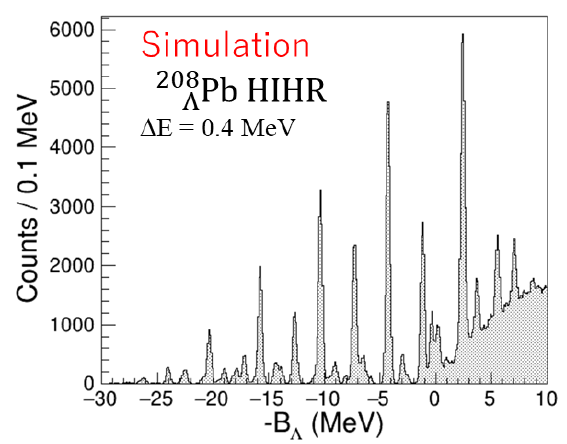
Figure 9. Expected Λ binding energy spectrum of 208 Λ Pb to be measured at HIHR. Major peaks are clearly observed, and sub-major peaks, which were previously treated as background due to the limited resolution of the experiments, can be also